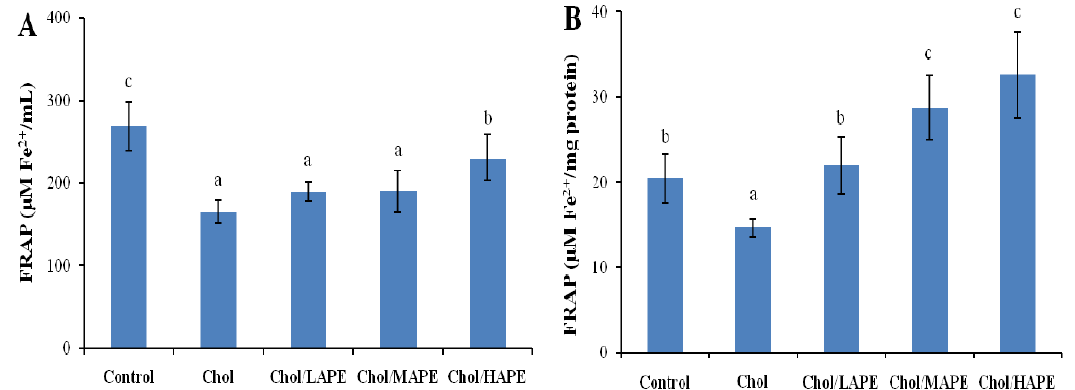
Figure 4. Effect of APE on antioxidant capacities of serum ( A ) and liver ( B ) in rats. Values are expressed as mean ± SD. Bars not sharing common letter superscripts are significantly different ( p <